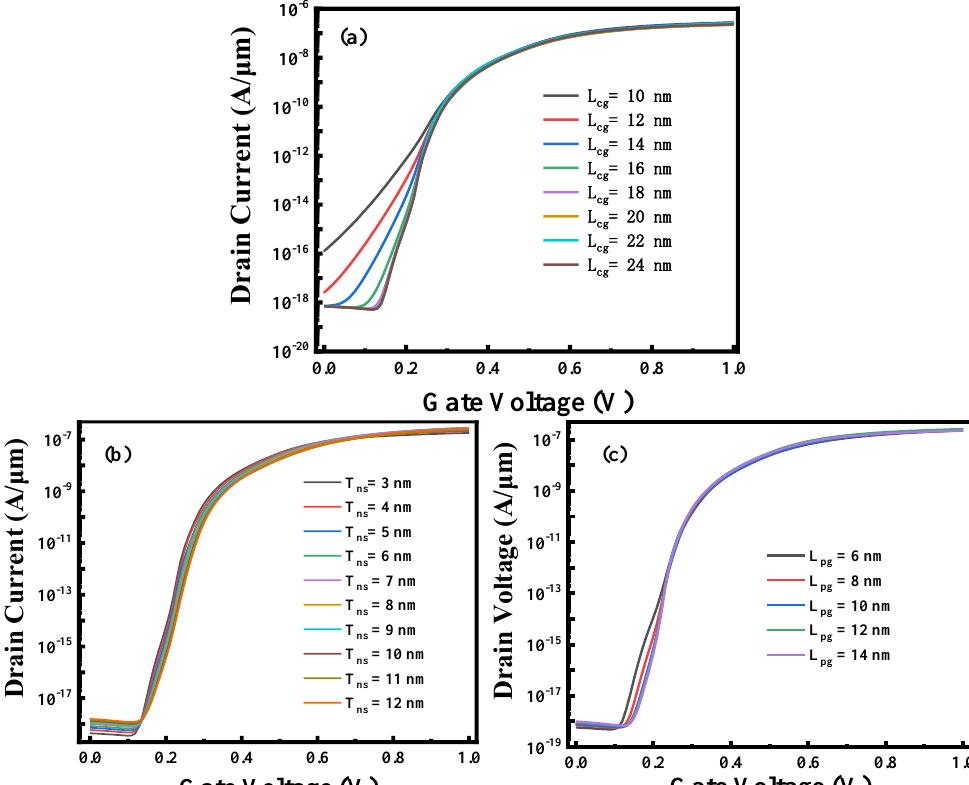
Figure 9. ( a ) Effect of control gate length on the transfer characteristics; ( b ) effect of nanosheet thickness on the transfer characteristics; ( c ) effect of polarity gate length on the transfer characteristics.